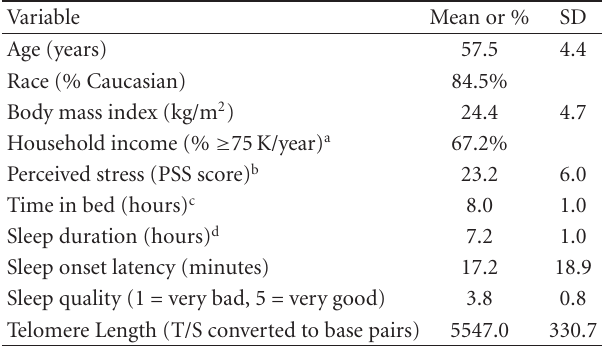
Figure 1: Subjective sleep quality is associated with leukocyte telomere length among participants for whom sleep quality rating reflected their “typical” sleep ( n = 201), adjusting for age, race, BMI, income, and perceived stress. Table 1: Characteristics of the study sample ( n = 245 unless other- wise noted).